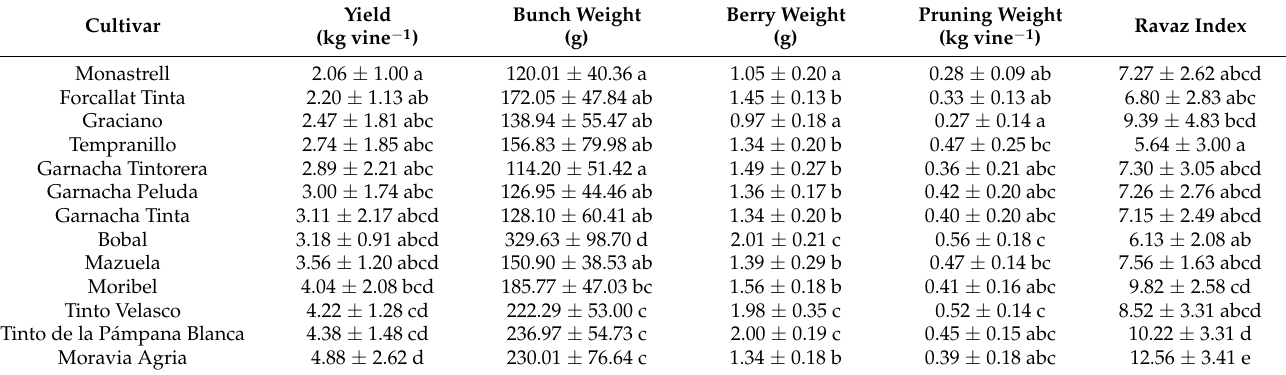
Table 1. Yield components and pruning weight (mean value ± standard deviation, n = 15) of 13 red cultivars.